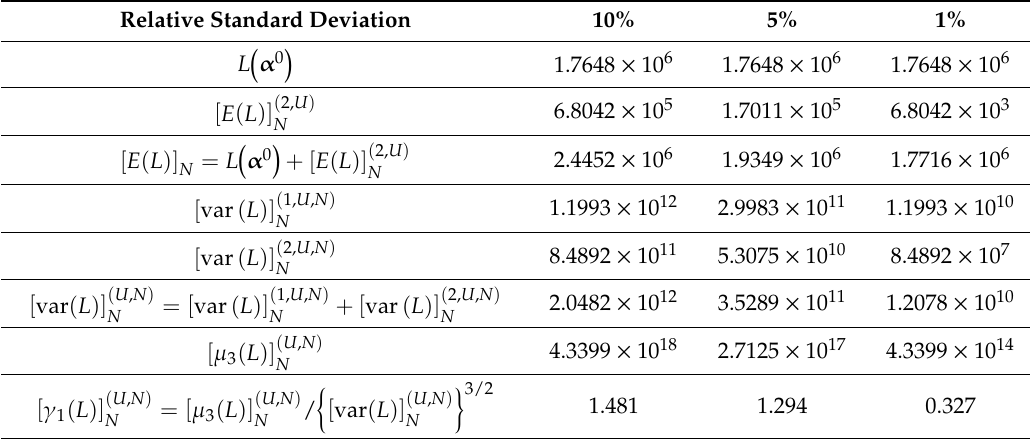
Table 4. Comparison of Response Moments Induced by Various Relative Standard Deviations Assumed for the Parameters N i , m